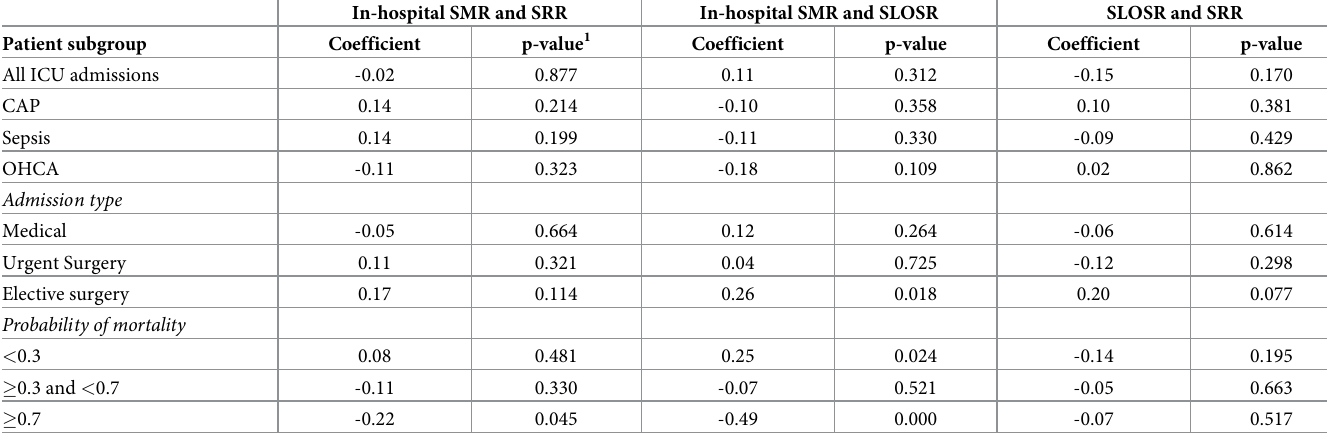
Table 2. Pearson’s correlation coefficients with corresponding p-values for the pairs of quality indicators standardized mortality ratio (SMR); standardized read- mission ratio (SRR) and standardized ICU length of stay ratio